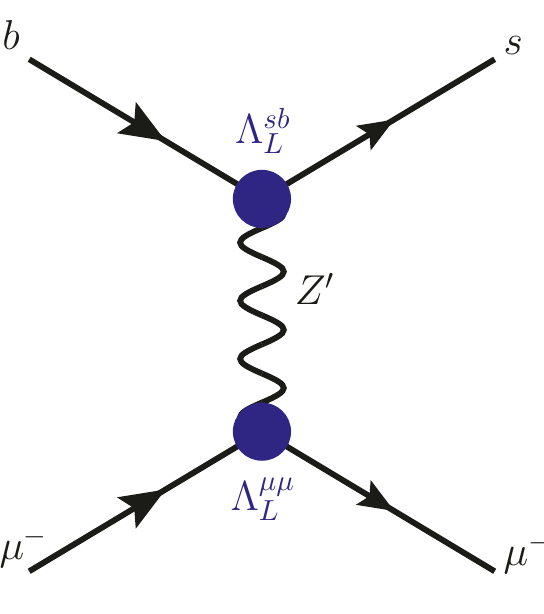
Figure 2 . Feynman diagram for b → sµ + µ −